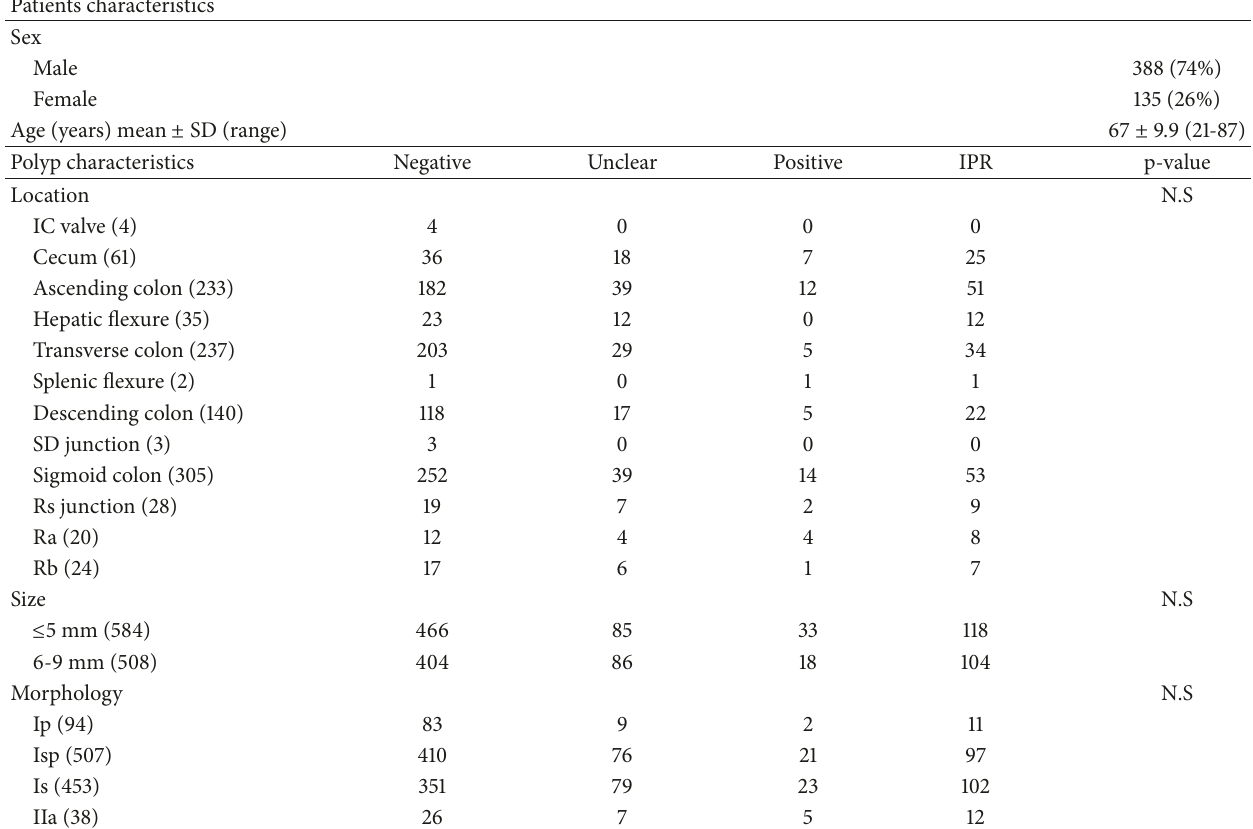
Table 1: Patient and polyp characteristics.